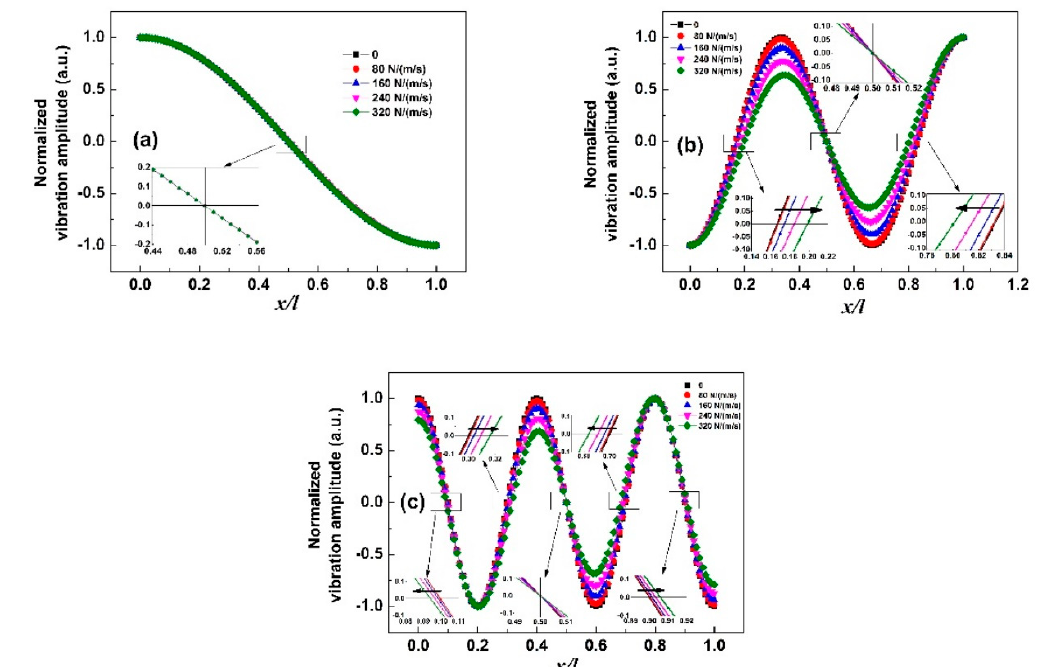
Figure 2. Vibration mode shapes of the sensor in air and in liquid with different viscous damping coefficient: ( a ) first-order resonance; ( b ) third-order resonance; and ( c ) fifth-order resonance. Here, the target loading position x c / l = 0.1 is used as an example.